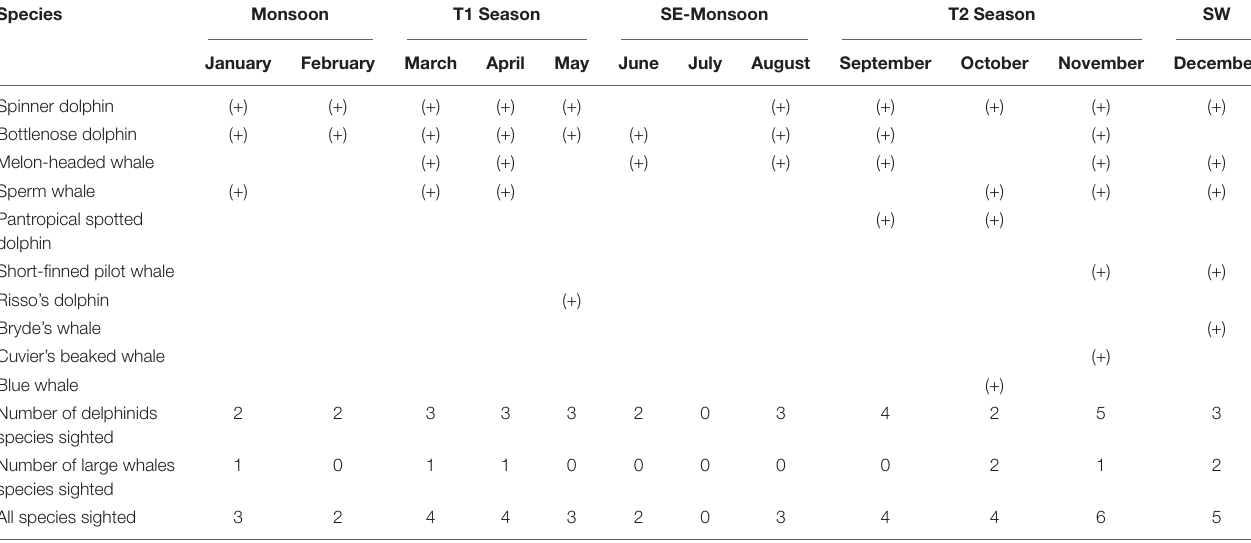
TABLE 3 | Seasonal occurrence: whale and dolphin species sighted in different months between May 2004 and May 2012 in Wakatobi (using all dataset). Species